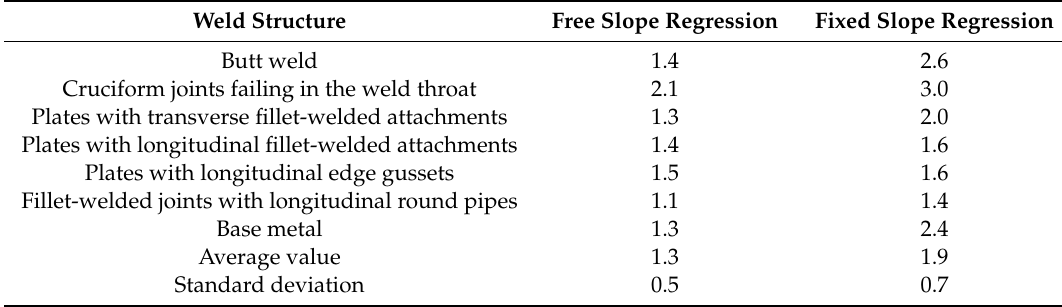
Table 3. Scatter indexes of the characteristic S – N curve of a typical weld